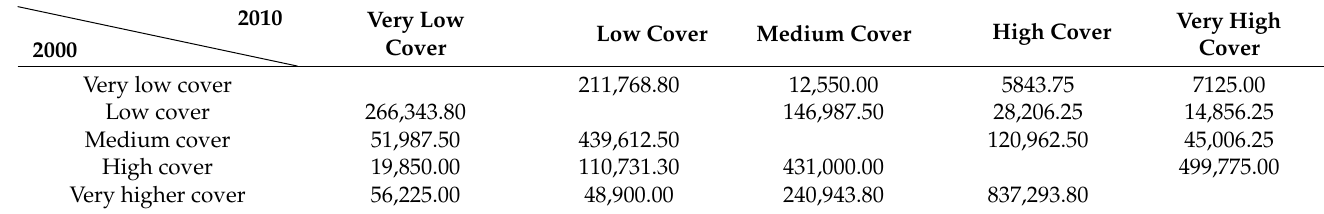
Table 6. FVC transition matrix from 2010 to 2018 (hm 2